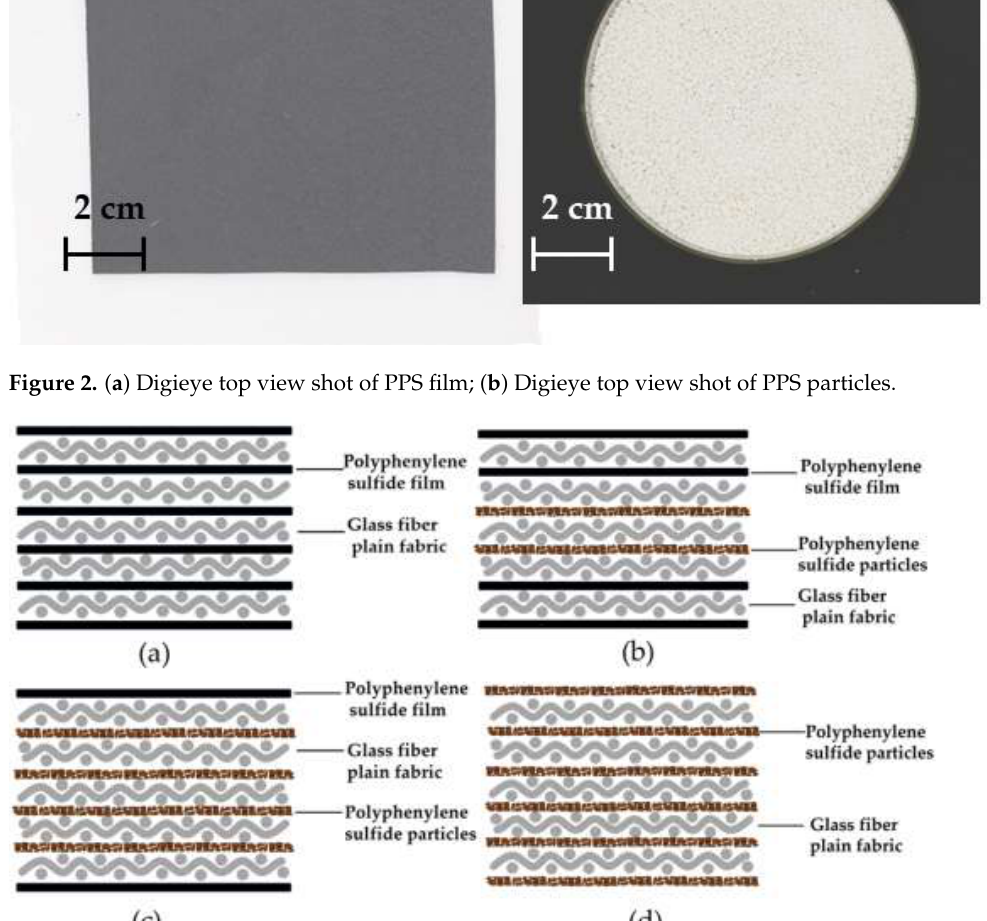
Figure 2. ( a ) Digieye top view shot of PPS film; ( b ) Digieye top view shot of PPS particles.